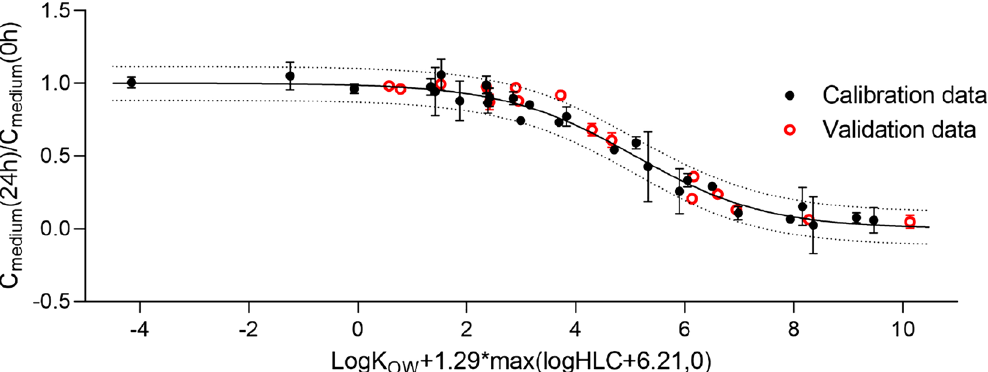
Figure 4. Validation of the empirical model for an adhesive foil covering the 24-well plates containing RTgill-W1 cells. The ratio of measured chemical concentration in the medium after 24 h of exposure and at the beginning of the experiment is plotted versus chemical log K OW and logHLC.